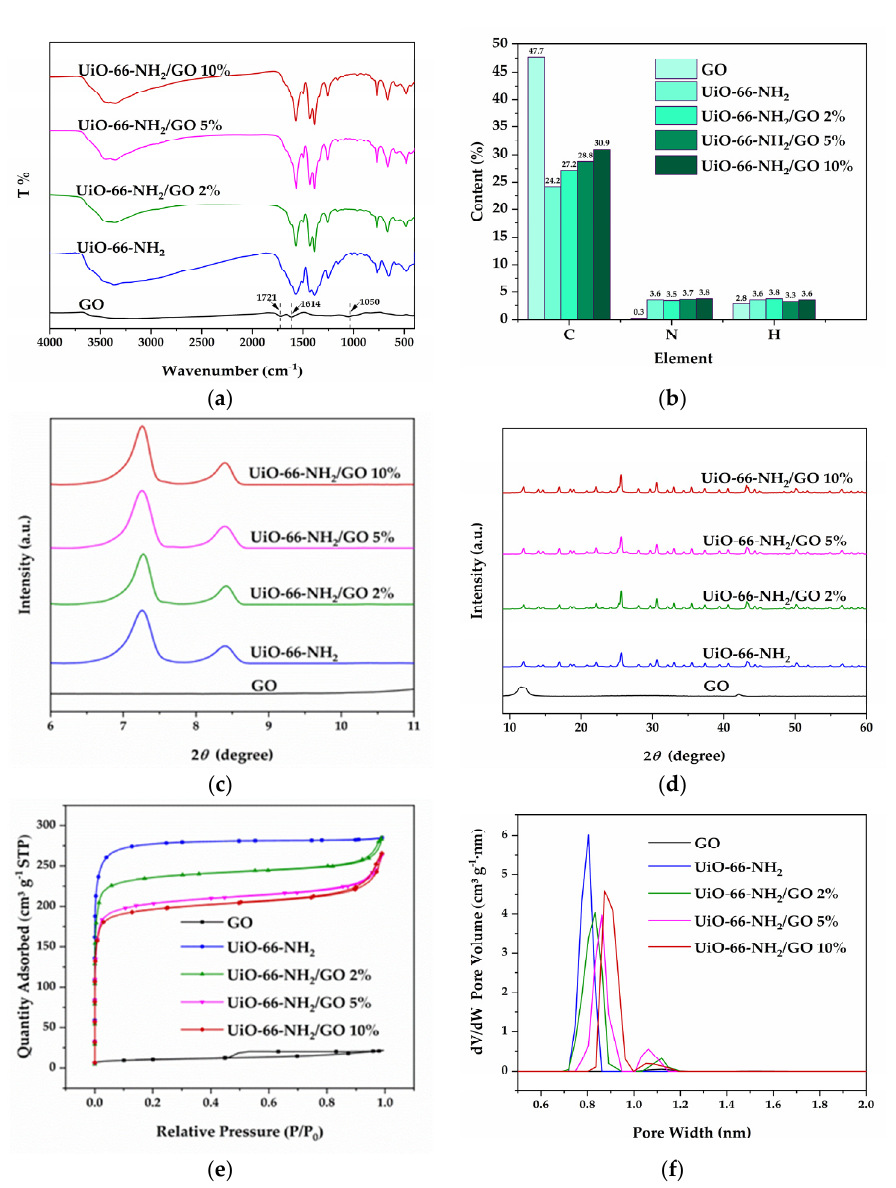
Figure 5. FTIR spectrum ( a ) and elemental contents ( b ) and XRD pattern ( c , d ) and N 2 adsorption–desorption isotherms curves ( e ) and pore size distributions ( f ) of UiO-66-NH 2 /GO Y%. Figure 5c,d showed the XRD pattern of UiO-66-NH 2 /GO Y%. For GO, the broad XRD characteristic peak at 11.60° reflected the layered structure of GO. The UiO-66-NH 2 /GO Y% had consistent characteristic peaks with UiO-66-NH 2 , which showed that UiO-66-NH 2 in the composites still maintained a high degree of crystallini- ty. In addition, the loading UiO-66-NH 2 promoted the layer exfoliation of GO, but GO